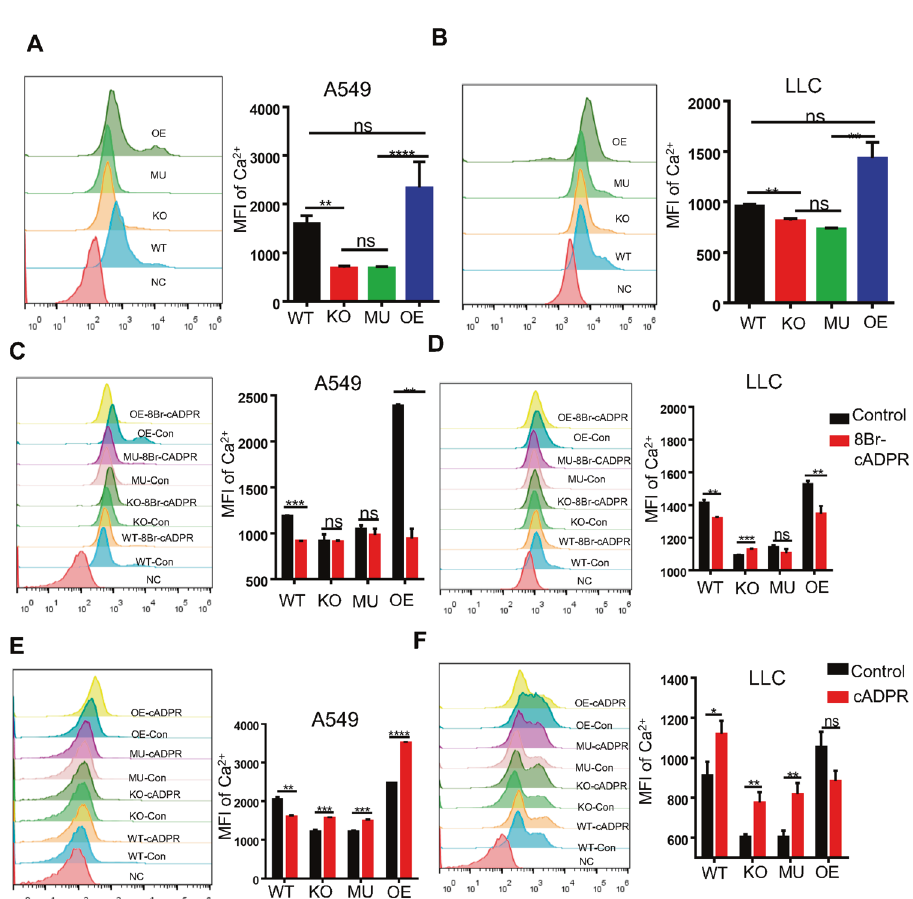
Fig. 4 cADPR promoted the concentration of cytoplasmic Ca 2 + . A , B FACS analysis was used to detect the MFI of cytoplasm Ca 2 + in A549 ( A , left) and LLC ( B , right) tumor cells ( n = 3). C , D FACS analysis showed the MFI of cytoplasm Ca 2 + in A549 ( C , left) and LLC (D, right) tumor cells treated with 8-Br-cADPR (for A549 was 20 μ M, for LLC was 10 μ M) for 1 h ( n = 3). E, F FACS analysis showed the MFI of cytoplasm Ca 2 + in A549 ( E , left) and LLC ( F , right) tumor cells added with cADPR ((for A549 was 100 nM, for LLC was 50 nM) for 1 h) for 0.5 h ( n = 3). Data were shown as mean ± SEM. ANOVA or test was used to analyze data. ns, no signi fi cant difference; * P < 0.05; ** P < 0.01; *** P < 0.001, **** P <